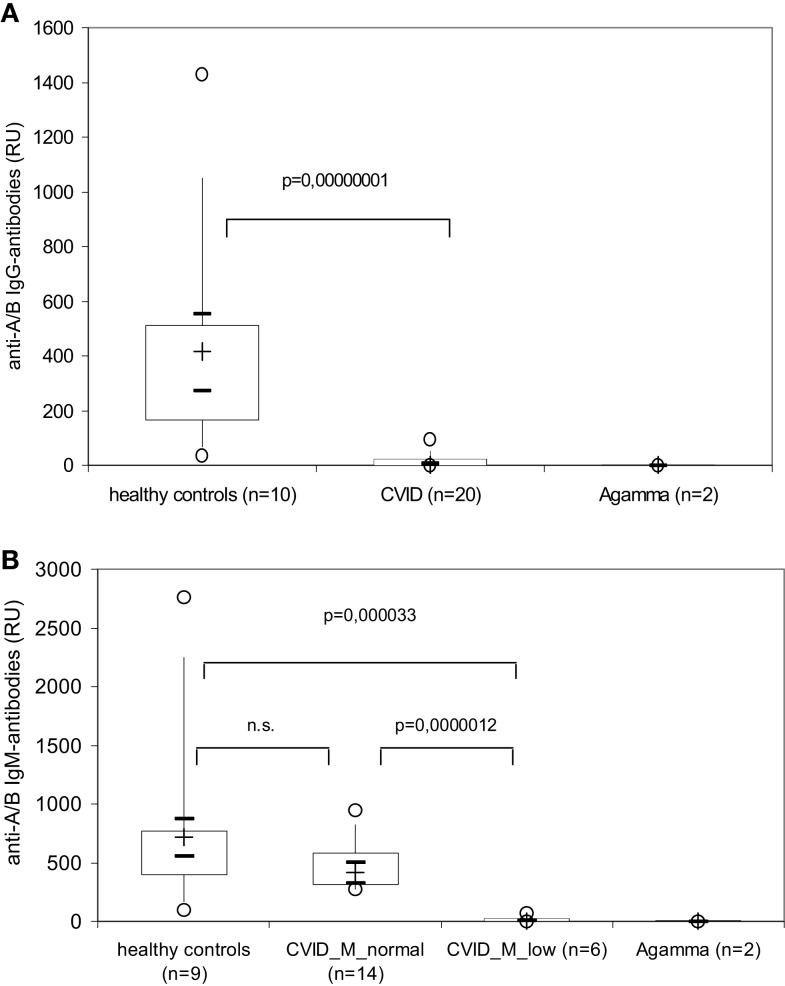
Isotype-specific measurement of anti-A/B antibodies by surface plasmon resonance using the Biacore® device in healthy controls, patients with CVID and XLA patients (Agamma). The amount of IgG- (upper panel) and IgM- (lower panel) anti-A/B antibodies present in the serum sample are depicted as resonance units (RU) using box plot diagrams, the median of the study group is represented by a cross, the interquartile range (IQR) is represented by the box, 5- and 95-percentile values are represented by the whiskers, and minimum and maximum values are represented by circles. The 95% confidence interval for the median calculated according to McGill et al. (21) is indicated by horizontal bars. The non-parametric Mann–Whitney U-test (two-sided P value) was used for statistical comparison between patients and healthy controls. CVID_M_low, CVID patients with very low to undetectable anti-A/B IgM-antibodies; CVID_M_normal, CVID patients with anti-A/B IgM-antibody titers that were comparable to the healthy control group.